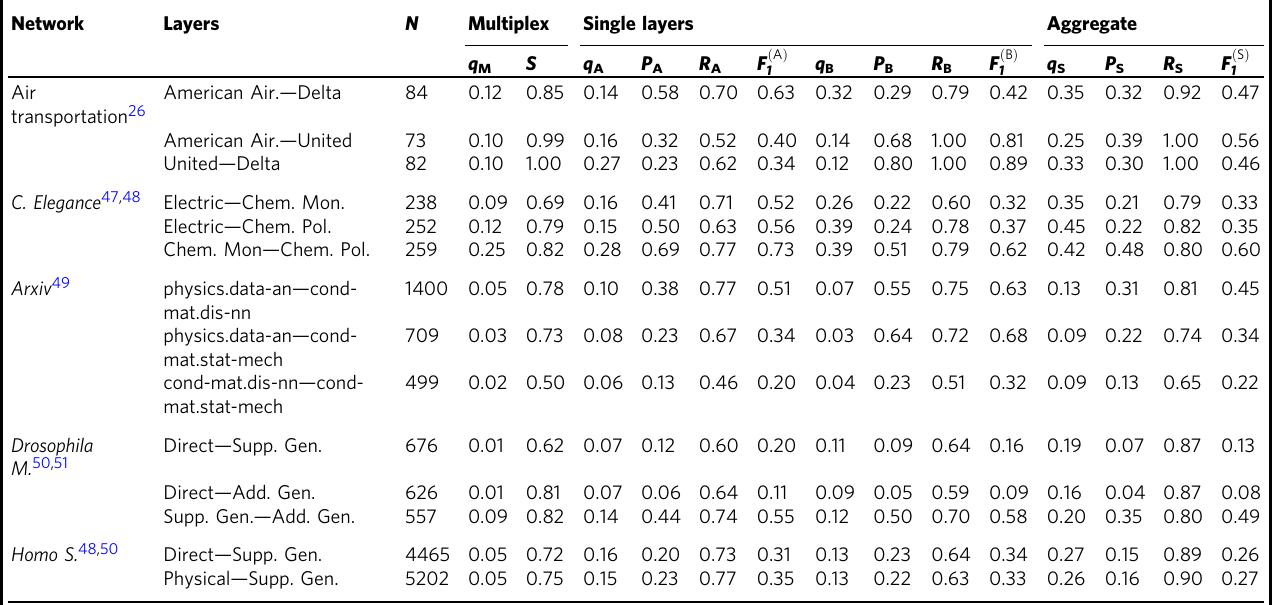
Table 1 Optimal percolation on real multiplex networks Network